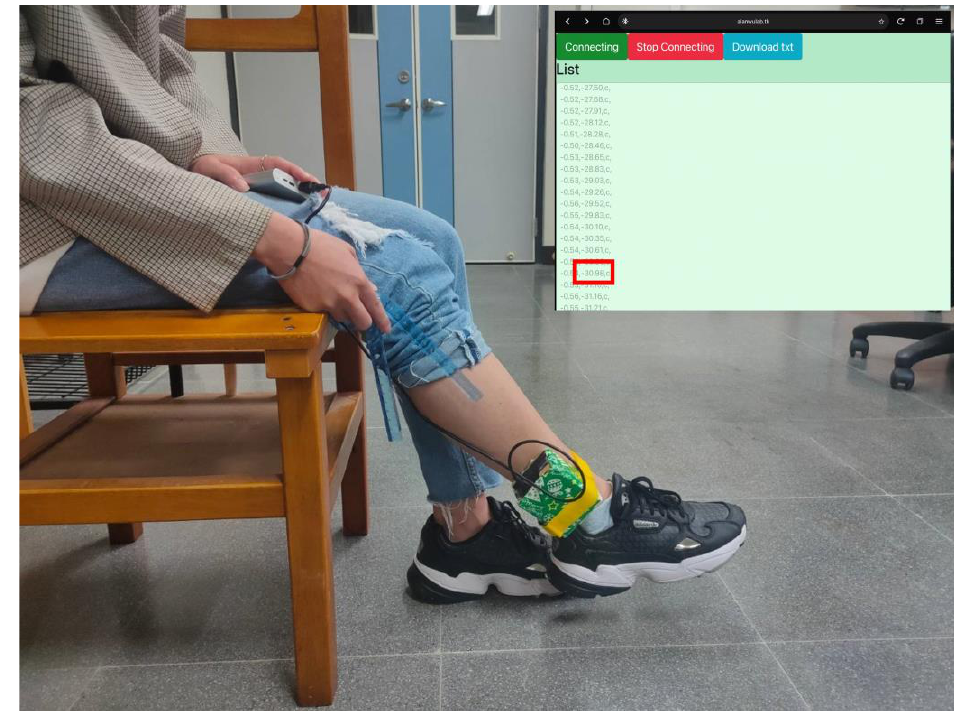
Figure 11. Angle detection of CPGAFDWD in iOS.